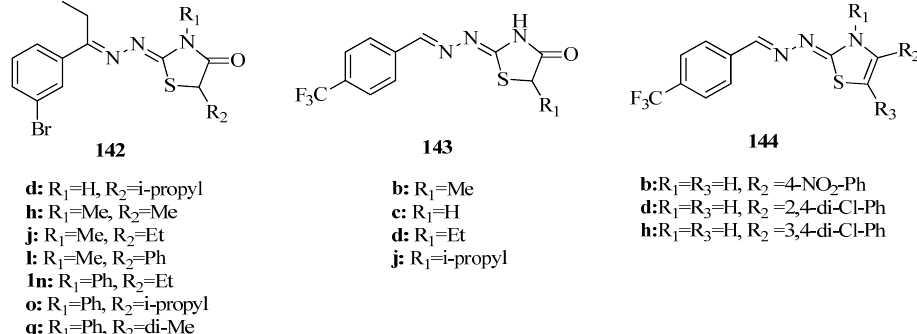
Figure 57. Structure of 4-thiazolidinone and 1,3-thiazole derivatives.